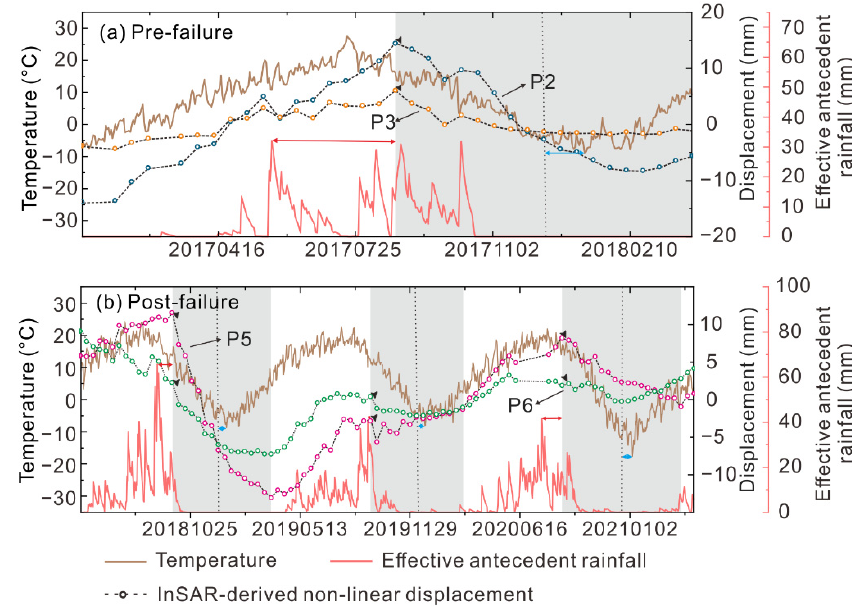
Figure 12. Time-series InSAR with linear trend removal, effective antecedent rainfall and temperature. The locations of P2 and P3 are shown in Figure 6. The locations of P5 and P6 are shown in Figure 8. The black triangles denote the initiation of the accelerated change. The gray bar represents the time span of the accelerated displacement. The red arrows represent the gap between the accelerated change and the peak in previous effective rainfall. The blue arrows represent the gap between the midpoint of the time span of the accelerated displacement and the lowest temperature value.